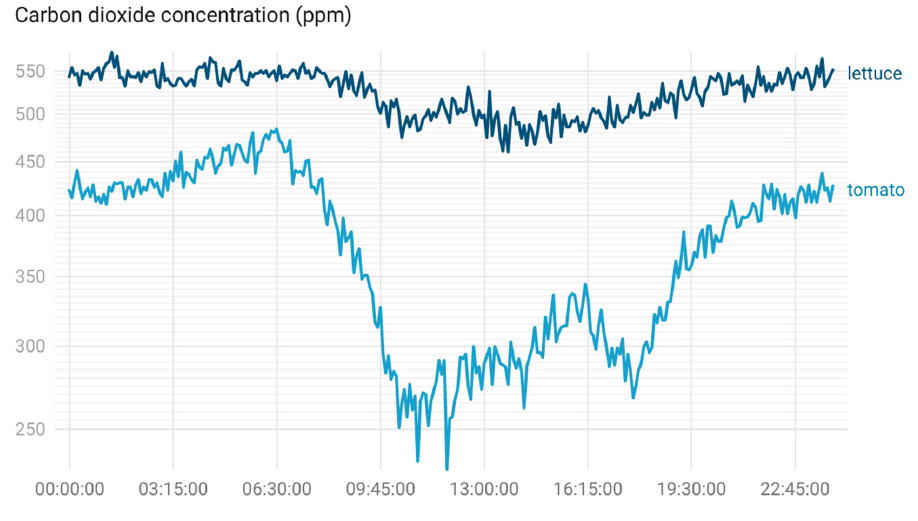
Figure 9. The change in carbon dioxide concentration in two greenhouses. Table 10. The R 2 of each model (time series features).